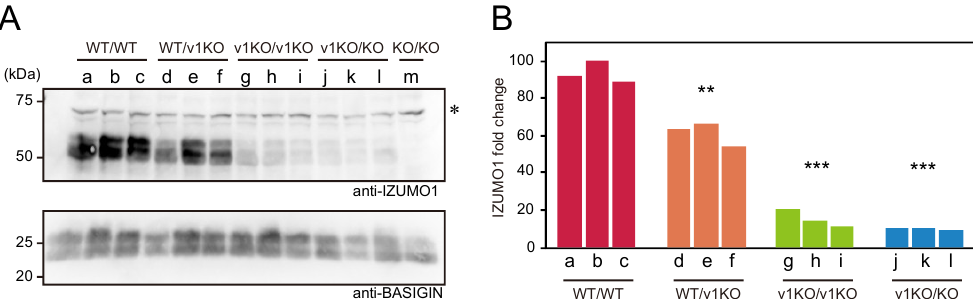
Figure 1. Evaluation of protein levels for IZUMO1 analyzed by western blotting. ( A ) Western blotting analysis with 2.2 μg/mL of monoclonal anti-IZUMO1 antibody (Mab18). Sperm lysates (30 μg) were applied onto each lane from an individual derived from five mouse lines (WT/WT; a–c, WT/v1KO; d–f, v1KO/v1KO; g–i, v1KO/KO; j–l and KO/KO; m). The alphabetical letters indicate individual specimens. BASIGIN is used as an internal control. The asterisk indicates non-specific bands. ( B ) Relative quantification for IZUMO1 protein normalized using BASIGIN. The color scheme is as follows: WT/WT; red, WT/v1KO; orange, v1KO/v1KO; light green, v1KO/KO; blue. Significant di ff erences: ** p < 0.01 and *** p < 0.001 (Student’s t -test) compared to WT /